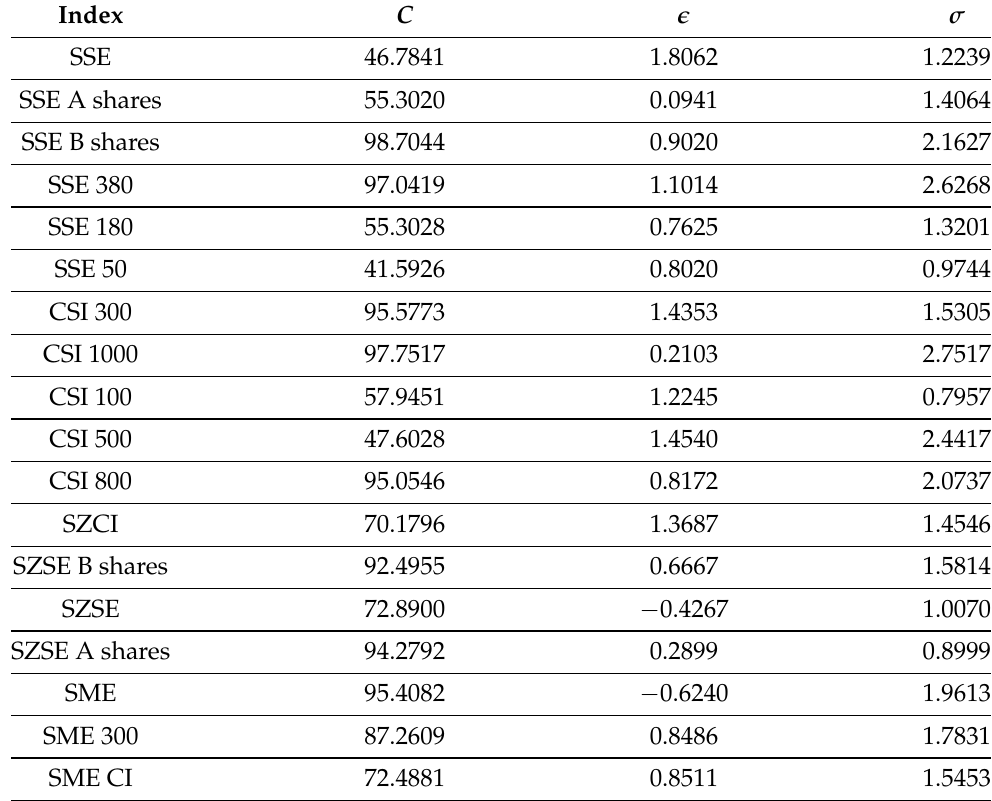
Table 11. SVR parameters obtained by long-term bat algorithm